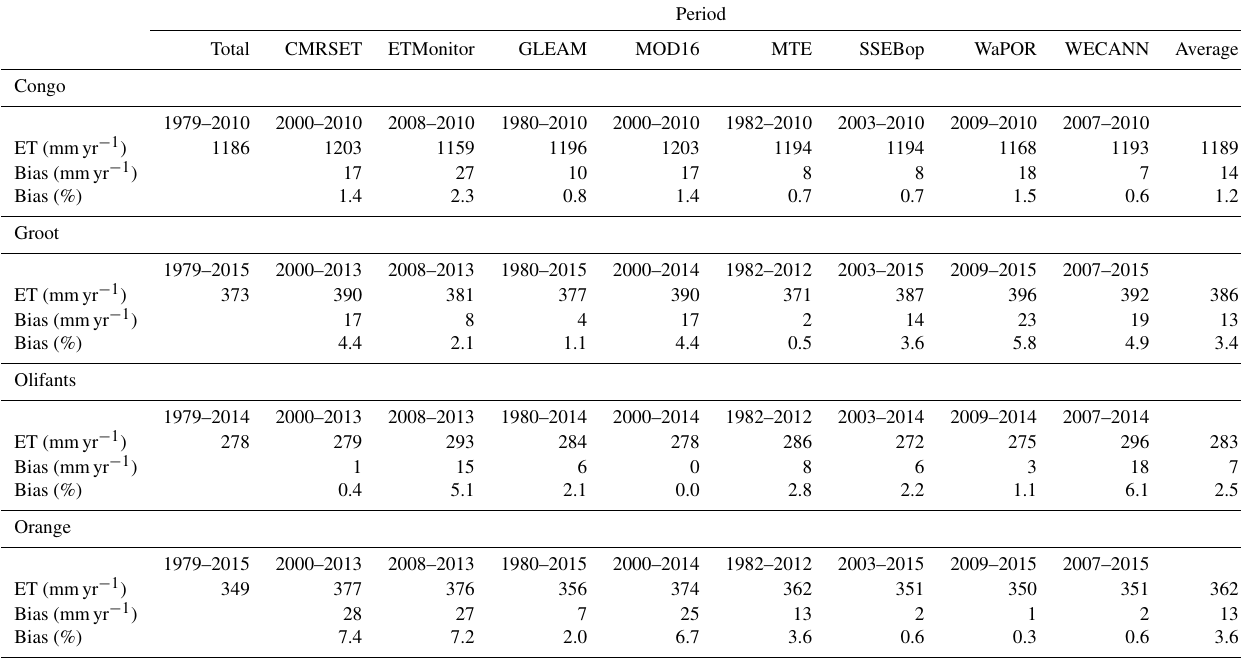
Table 10. Differences in mean ET WB estimations for varying RS product periods.